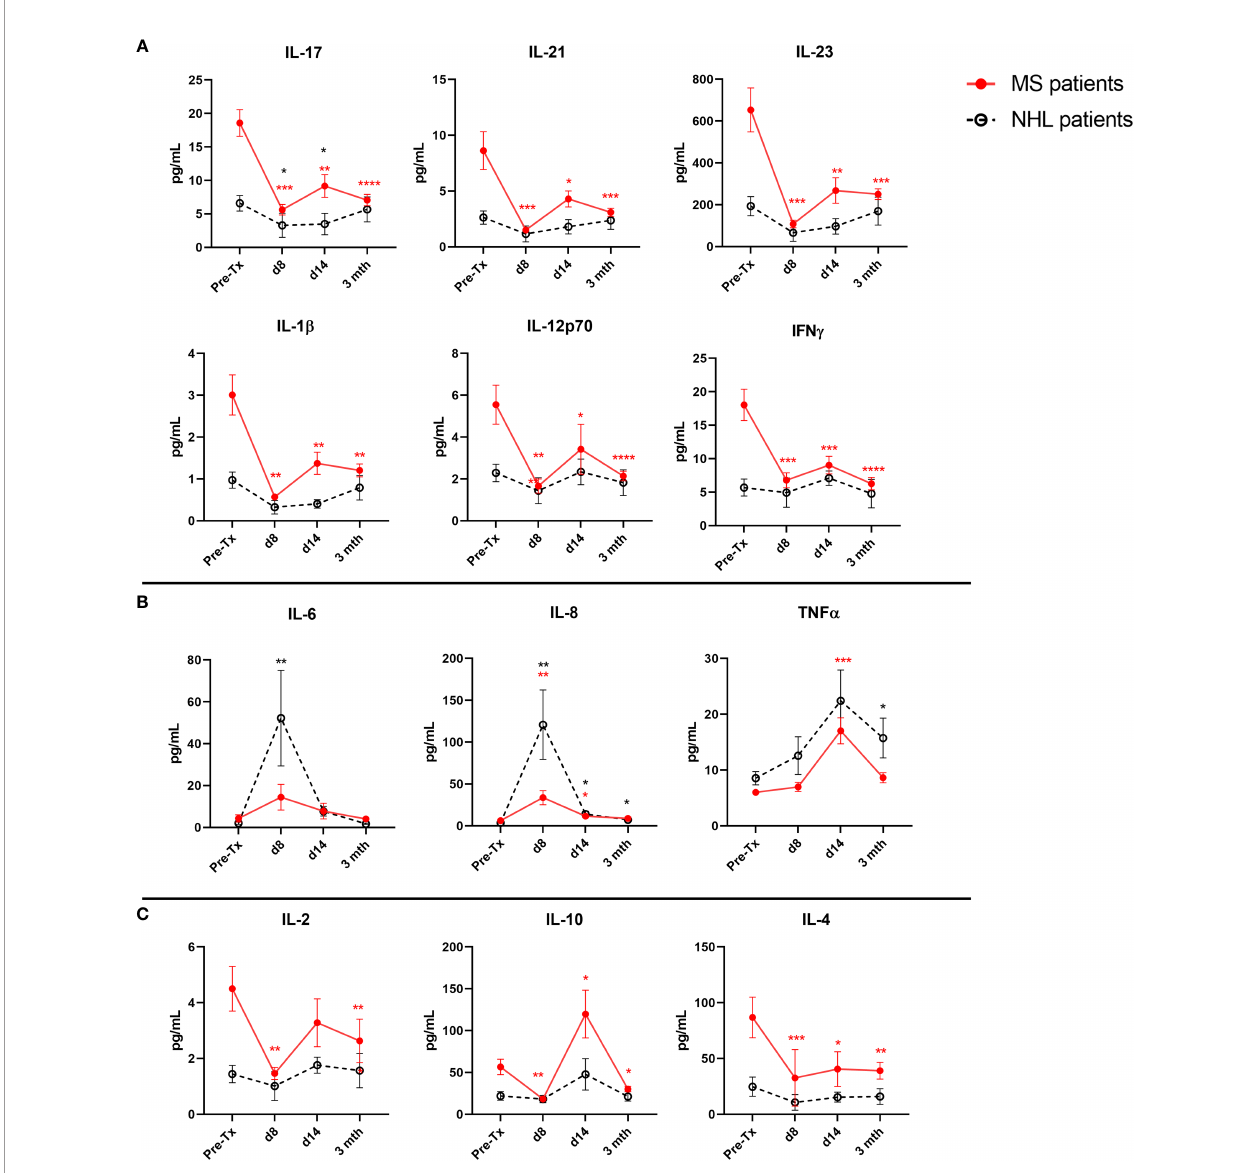
FIGURE 1 | Early post-AHSCT changes to plasma cytokine levels in MS and NHL patients. Cytokine concentrations were quanti fi ed at pre-AHSCT (pre-Tx), day 8 (d8), day 14 (d14), and 3 months (mth) post-AHSCT. (A) Immediate suppression of several T cell-associated proin fl ammatory cytokines were observed early after transplantation (Th17: IL-17, IL-21, IL-23, and IL-1 b ; Th1 IL-12p70 and IFN g ) in MS patients. (B) Some proin fl ammatory cytokines exhibit early surges post-transplantation (IL-8, IL-6 and TNF a ) in both MS and NHL patients. (C) Plasma concentration of anti-in fl ammatory cytokines (IL-10, IL-4, and IL-2) at speci fi ed timepoints in patients undergoing AHSCT. MS cohort sample size is n=22, and NHL cohort sample size is n=9. Sample sizes per timepoint are as follows: 1) Pre-Tx: MS n=22; NHL n=9 2) d8: MS n=9; NHL n=5, 3) d14: MS n=10; NHL n=5, and 4) 3 months: MS n=21; NHL n=9. Analysis was performed using a one-way repeated measures ANOVA with Holm-Sidak post-hoc . * p < 0.05; ** p < 0.01; *** p < 0.001; **** p <